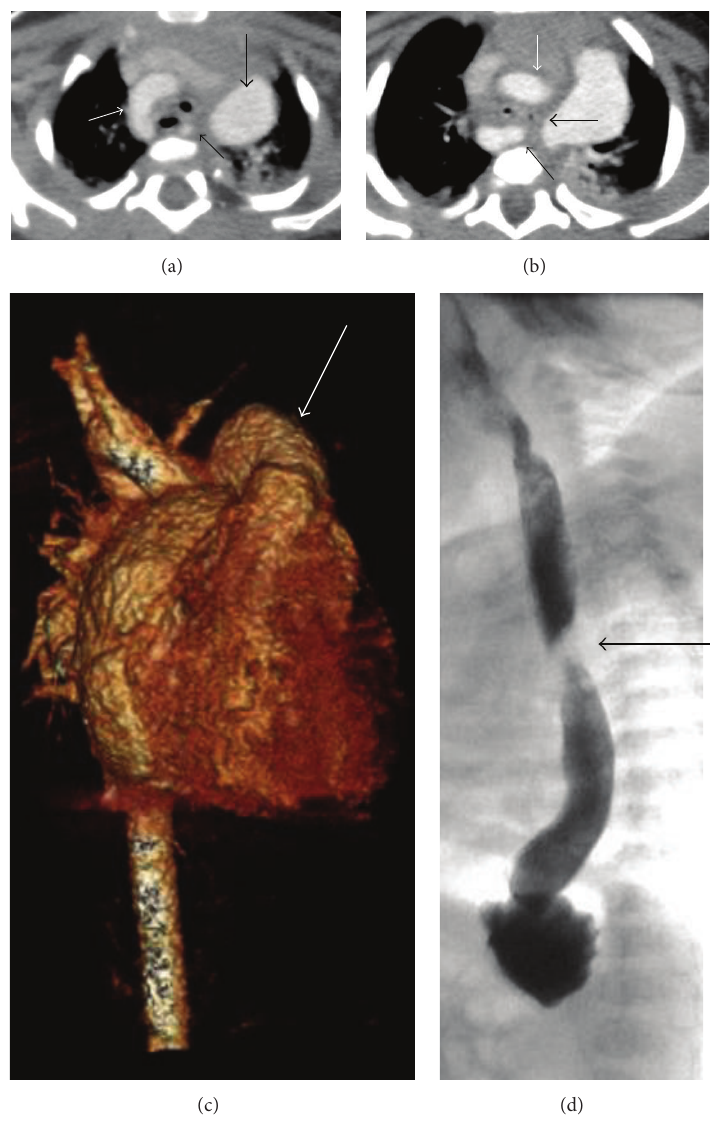
Figure 4: (a) Axial postcontrast CTA of the chest demonstrates a right aortic arch (white arrow). The aberrant left subclavian artery is seen extending posterior to the esophagus (thin black arrow) which helps form the complete vascular ring. The pulmonary artery was enlarged in this patient (thick black arrow). (b) Axial postcontrast CTA of the chest at a slice inferior to (a) demonstrates the ascending aorta projecting to the right (white arrow) and the aberrant left subclavian artery arising from the descending aorta and traveling posterior to the esophagus (thin black arrow). The complete vascular ring causes mass effect and narrowing of the esophagus and trachea (thick black arrow). (c) 3D surface rendered reformation of the CTA of the chest viewed in the anteroposterior dimension clearly demonstrates the right aortic arch (thick white arrow). (d) Fluoroscopic image of a barium esophagram demonstrates mass effect on the posterior esophagus (thick black arrow) created by the aberrant left subclavian